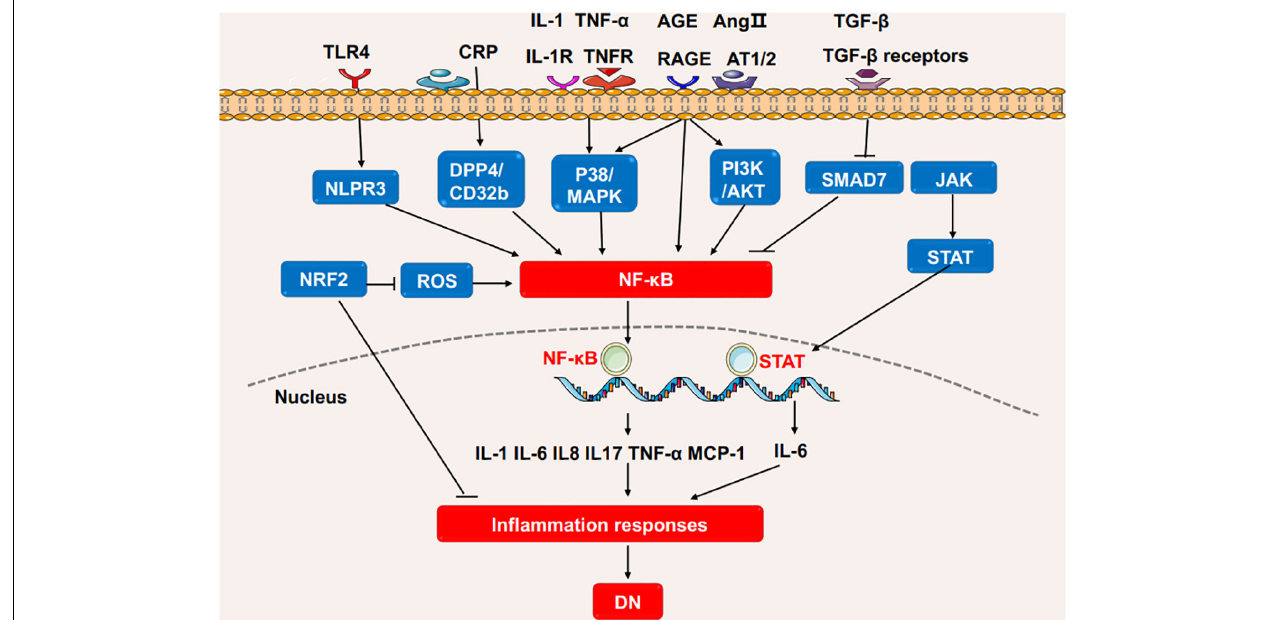
FIGURE 3 | The roles of DNA methylation and histone modification in the DN process. High glucose or stimulating factors cause DNA methylation and histone modification. DNA methylation is mainly regulated by DNMTs. MIC-1 and TIIA inhibits DNA methylation and reduces inflammation in DN. In the processes of histone modification, SET7/9 regulates H3K4 methylation, UTX regulates H3K27 demethylation, HAT promotes histone acetylation, and HDAC4/9 promotes histone deacetylation. The above processes regulate inflammatory genes, in turn affects the inflammatory response in DN. DN, diabetic nephropathy; DNMTs, DNA methyltransferases; UTX, ubiquitously transcribed tetratricopeptide repeat, X chromosome; HAT, histone acetyltransferases; HDAC, histone deacetylase; NF- κ B, Nuclear factor- κ B; MCP-1, monocyte chemoattractant protein-1; STAT1, Signal transducer and activator of transcription 1.